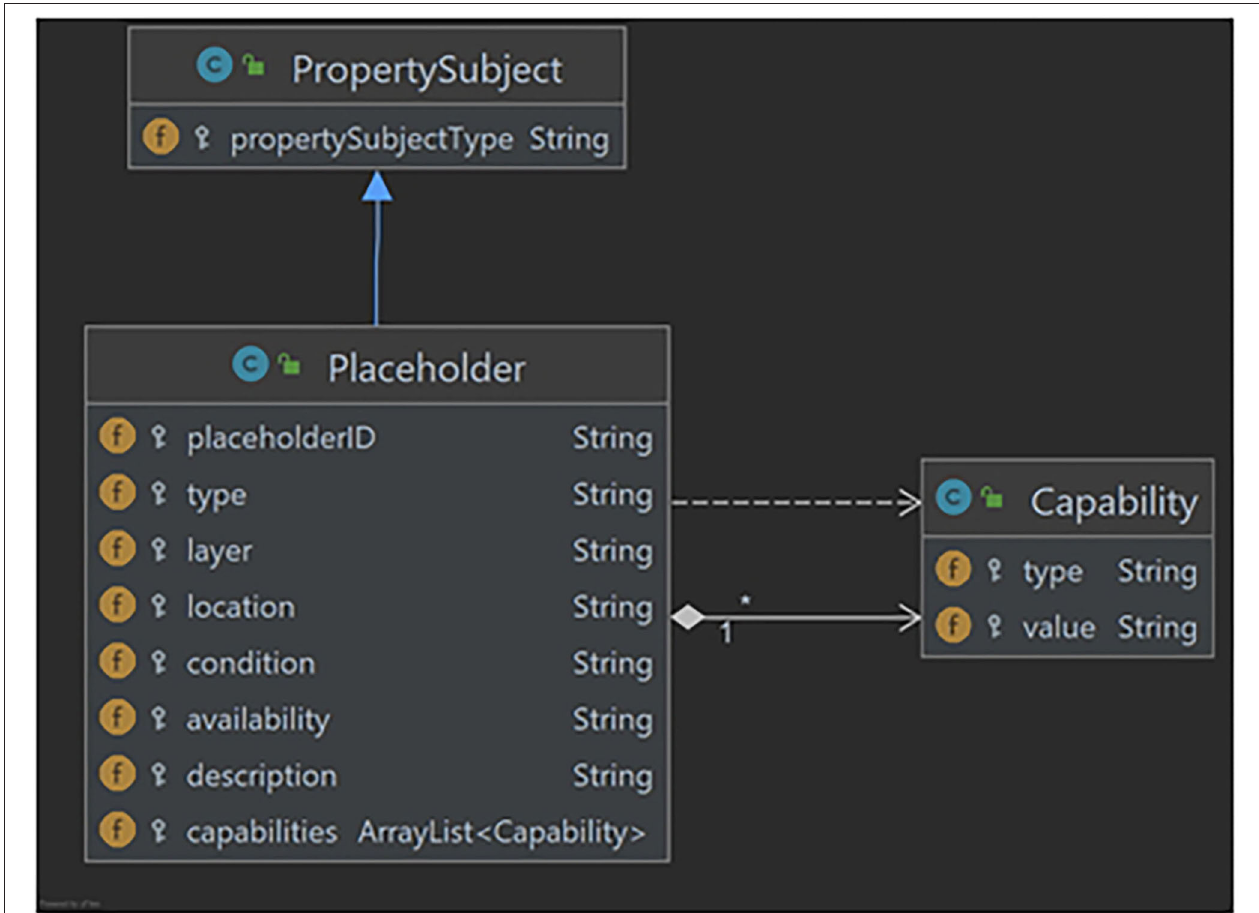
FIGURE 1 | Descriptive overview of the Placeholder, Capability, and PropertySubject